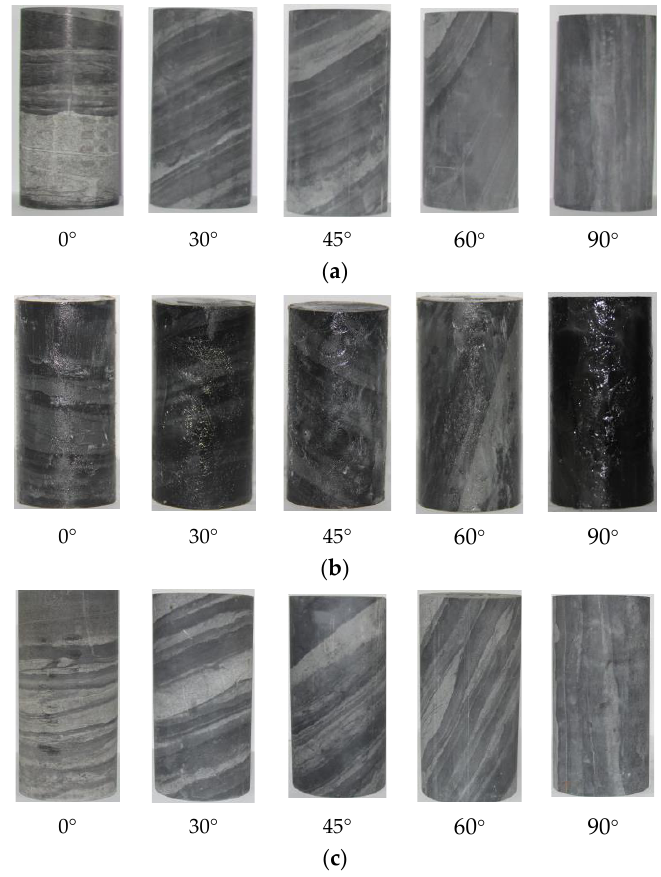
Figure 1. Rock samples after processed: ( a ) under natural state; ( b ) saturated state; ( c ) dry state.